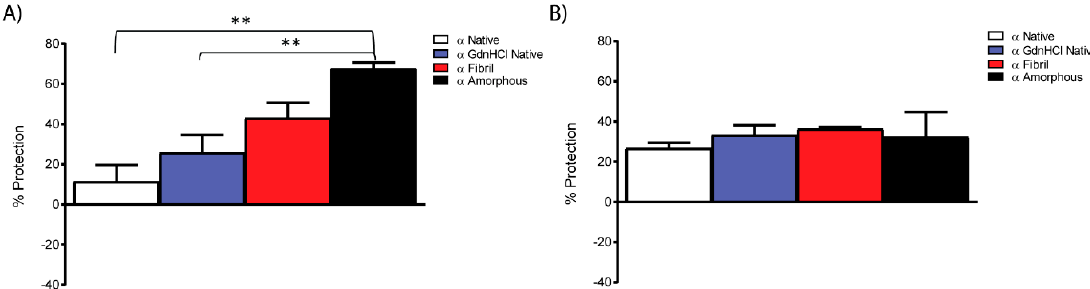
Figure 5. Chaperone protection provided by native, fibrillar and amorphous α B ‐ crystallin species against the ( A ) amorphous aggregation of insulin, 250 μ g/mL at 37 °C in 0.1 M sodium phosphate, 20 mM DTT, pH 7.4 (0.9 chaperone: 1.0 insulin on a molar basis); and ( B ) fibrillar aggregation of RCM κ‐ casein 400 μ g/mL, 10 μ M ThT at 37 °C, pH 7.4 (0.5 chaperone: 1.0 RCM κ‐ casein on a molar basis).